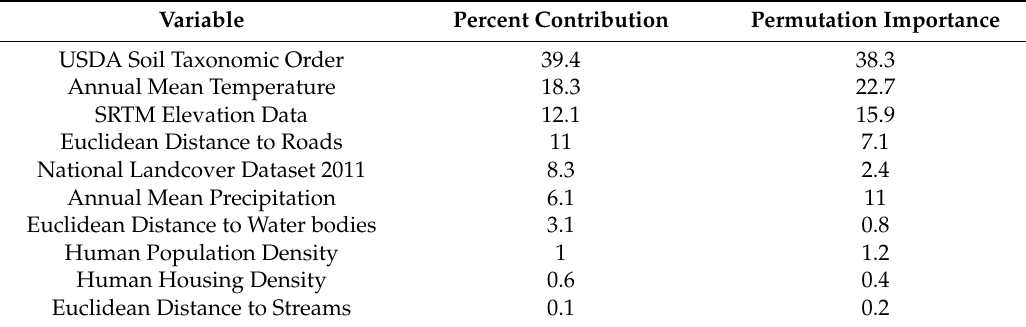
Table 6. Raccoon ( n = 1168) risk modeling sample data for pine-dominated landscapes of Alabama during 5 January 2012–26 June 2014. All values are means.